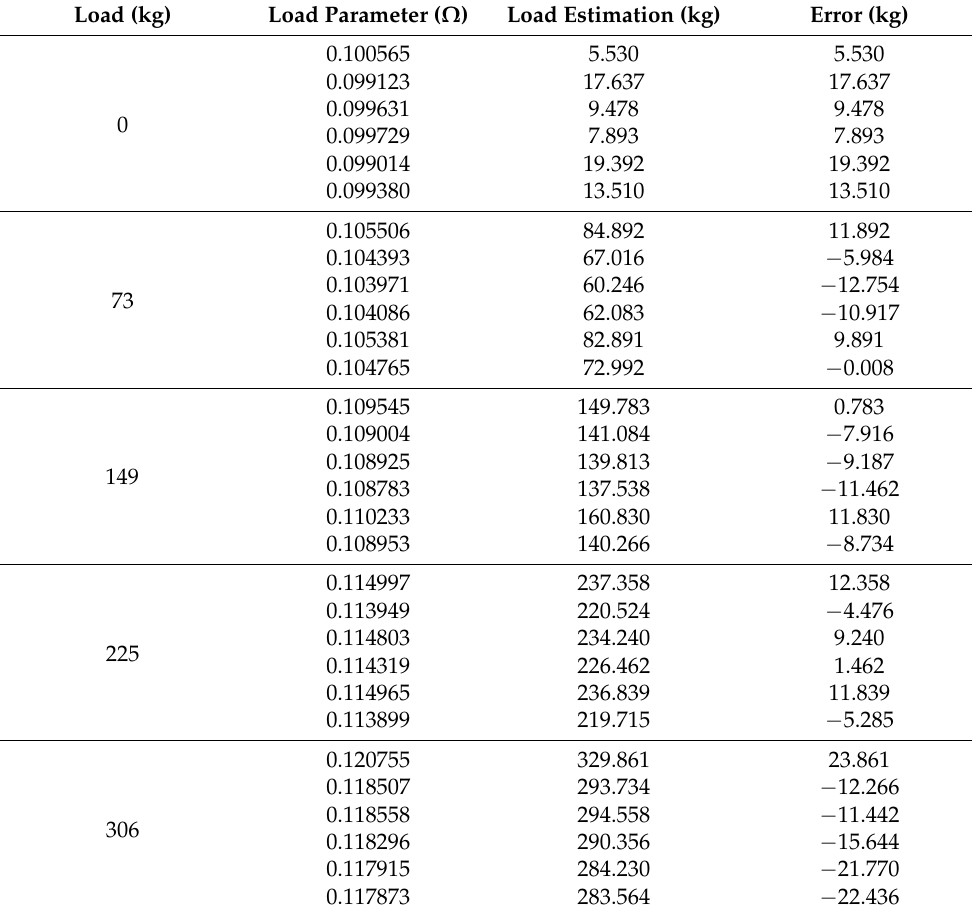
Table A2. Measurement data for Mercedes GLA200 test car.